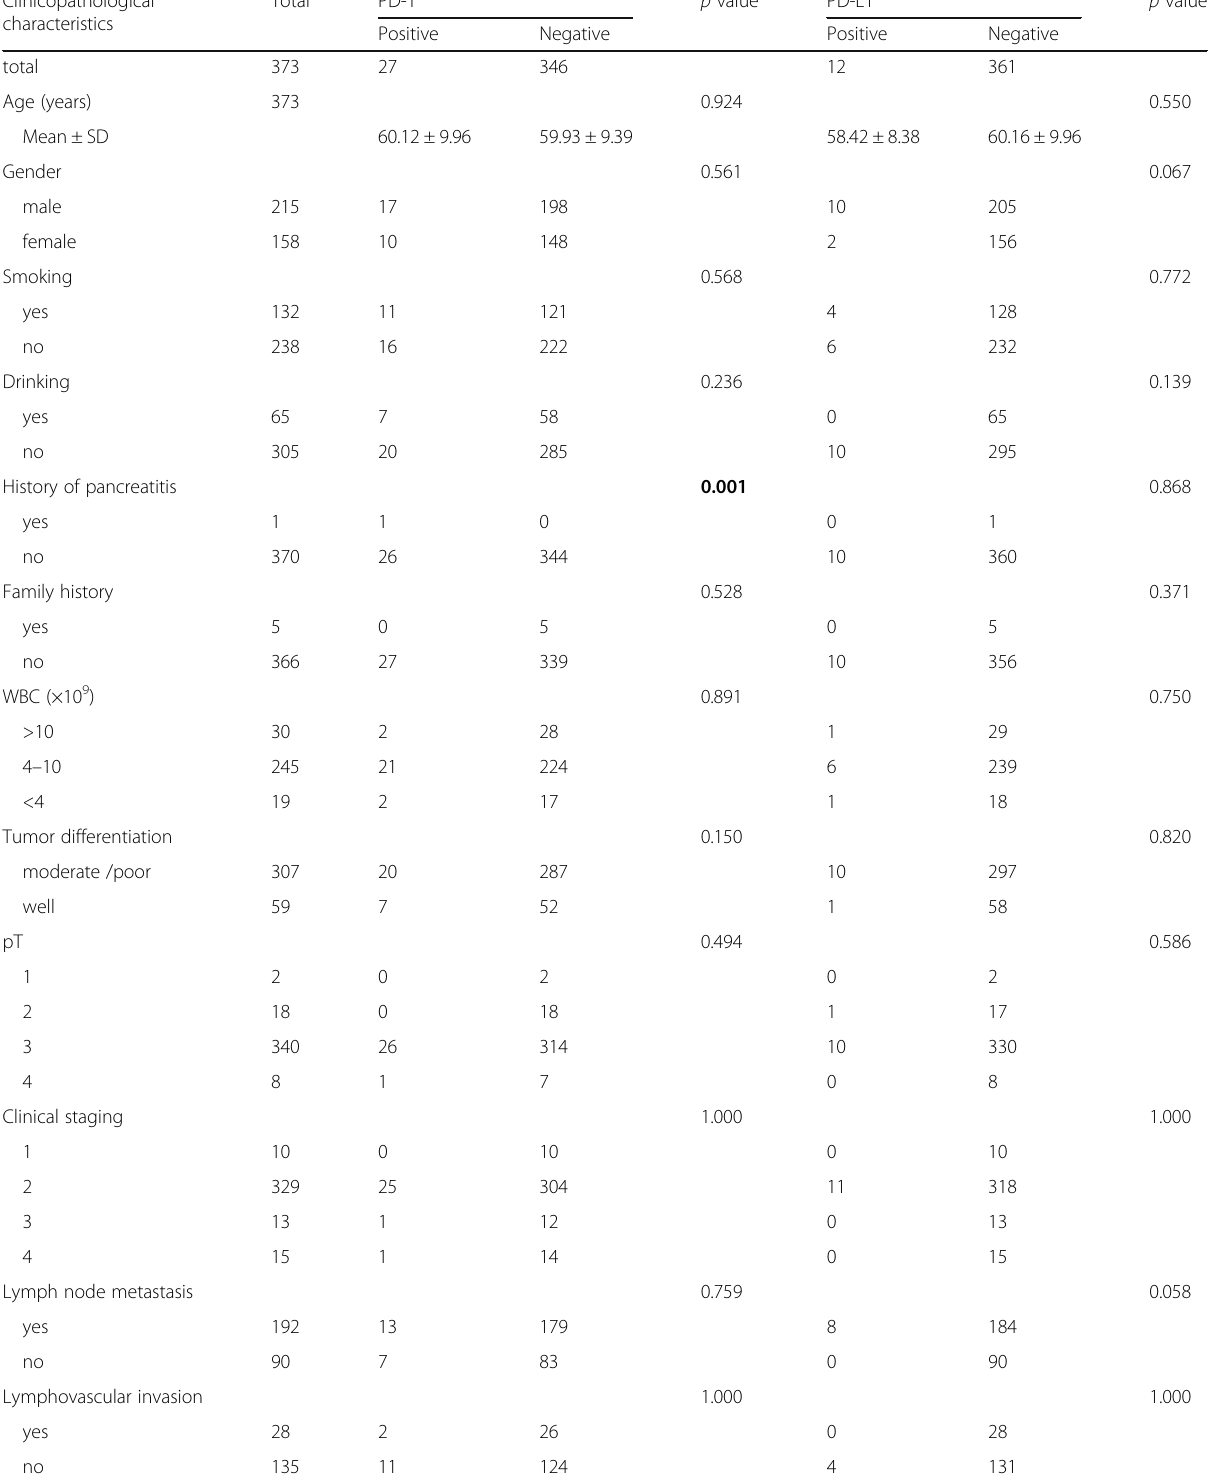
Table 1 Association between clinicopathological parameters and PD-L1 expression in 373 PDAC patients Clinicopathological